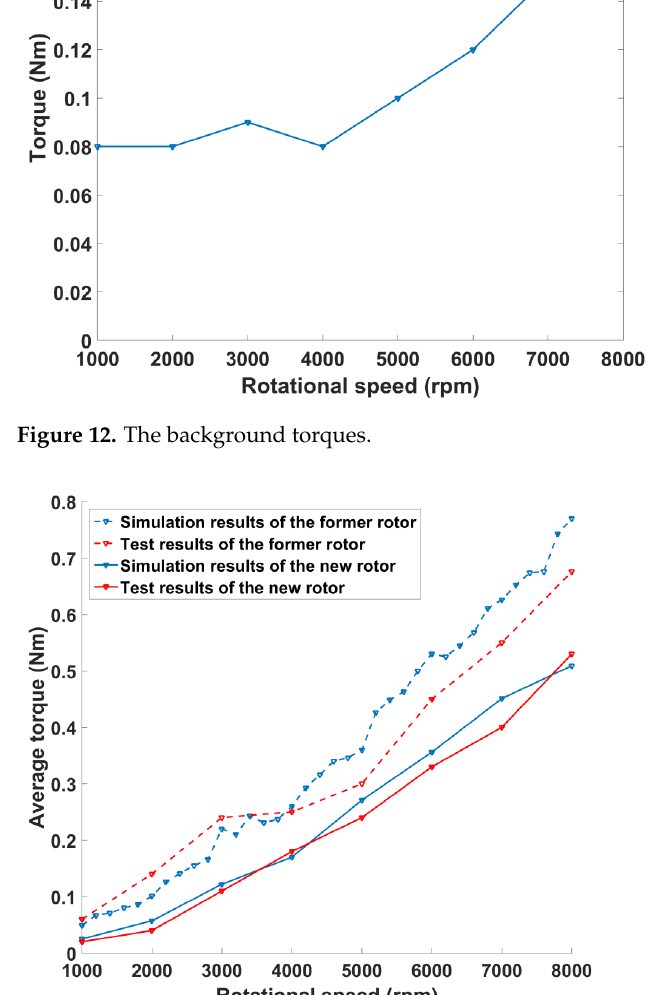
( b ) Figure 14. The torque distributions of the churning losses with different rotational angles: ( a ) at a rotational speed of 1000 rpm; ( b ) at a rotational speed of 8000 rpm. 5. Conclusions In this study, to reduce the churning losses occurring in either 2D pumps or 2D flow- meters, a new 2D motion-converting mechanism was presented with a detailed descrip- tion of its architecture and working principles. Afterwards, considering its comparability